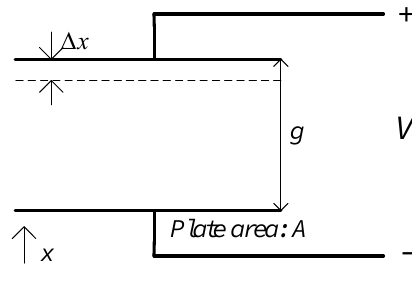
Figure 2 . Simplified illustration for a parallel plate capacitor.